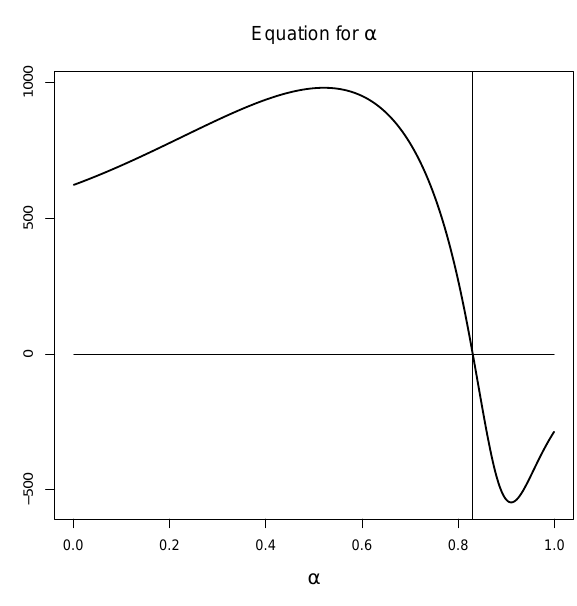
Figure 2. Graph of equation for α .